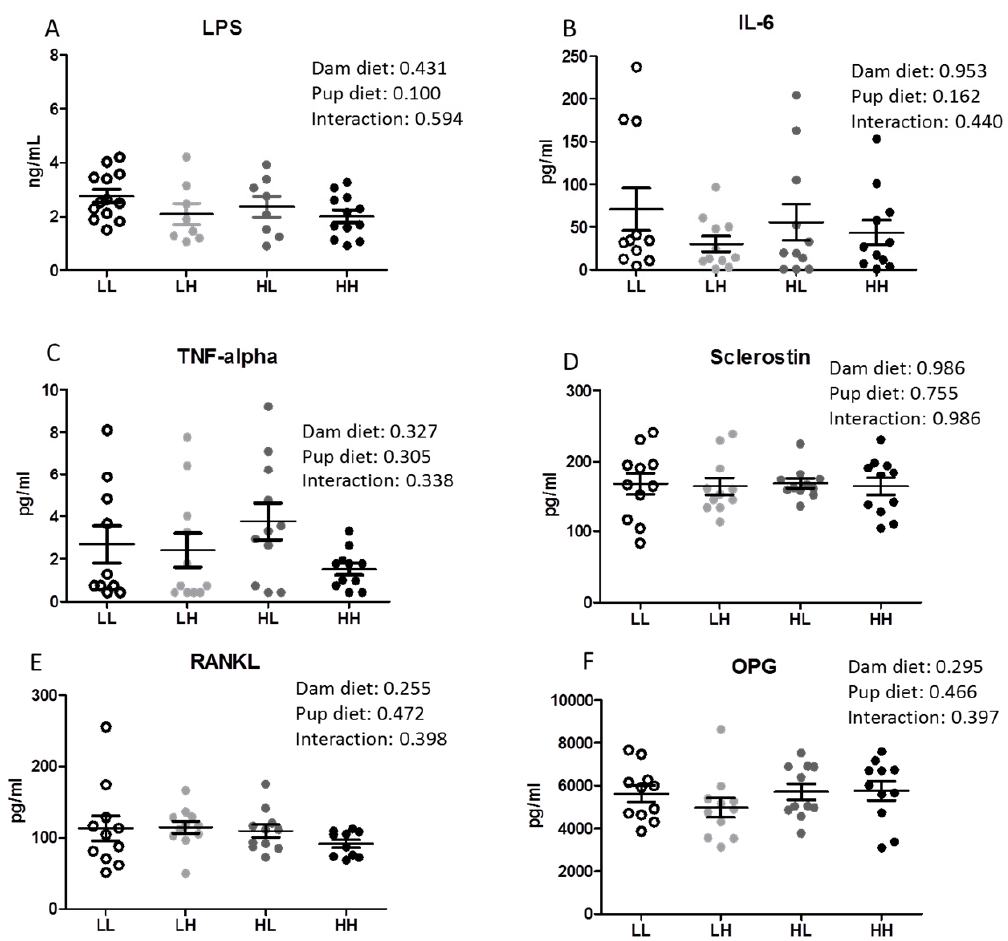
Figure 2. High dietary vitamin D does not reduce serum LPS concentrations in offspring seven months of age. ( A ) Serum LPS concentrations ( n = 8–13); ( B ) Serum interleukin ‐ 6 (IL ‐ 6, n = 11/group); ( C ) Serum tumor necrosis factor alpha (TNF ‐α , n = 11/group); ( D ) Serum sclerostin (SOST, n = 11/group); ( E ) Serum receptor activator nuclear factor kappa ‐ B ligand (RANKL, n = 11/group); ( F ) Serum osteoprotegerin (OPG, n = 11/group). Groups are labeled as LL and HH for offspring receiving low vitamin D or high vitamin D from conception until adulthood (25 IU/kg diet or 5000 IU/kg diet, respectively), or switched post-weaning (LH and HL). Two-way ANOVA with “dam diet” and “pup diet” as main effects was utilized for results. Values are given as mean ± SEM. Significance between groups set at p < 0.05.